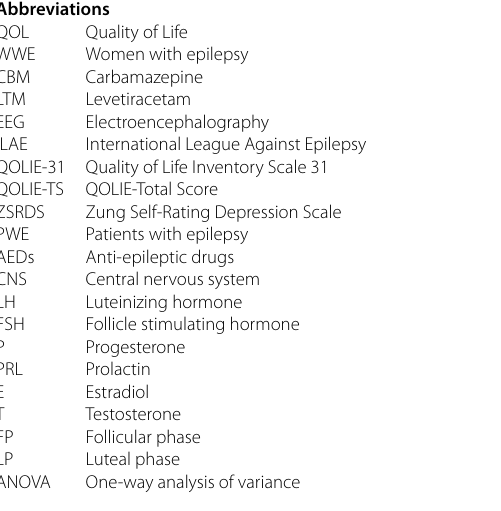
FSH follicle stimulating hormone, LH luteinizing hormone, FP follicular phase, LP luteal phase, LH:FSH: ratio of luteinizing hormone to follicle stimulating hormone, B Beta co-efficient, S.E standard error, CI confidence interval, t Student’s test